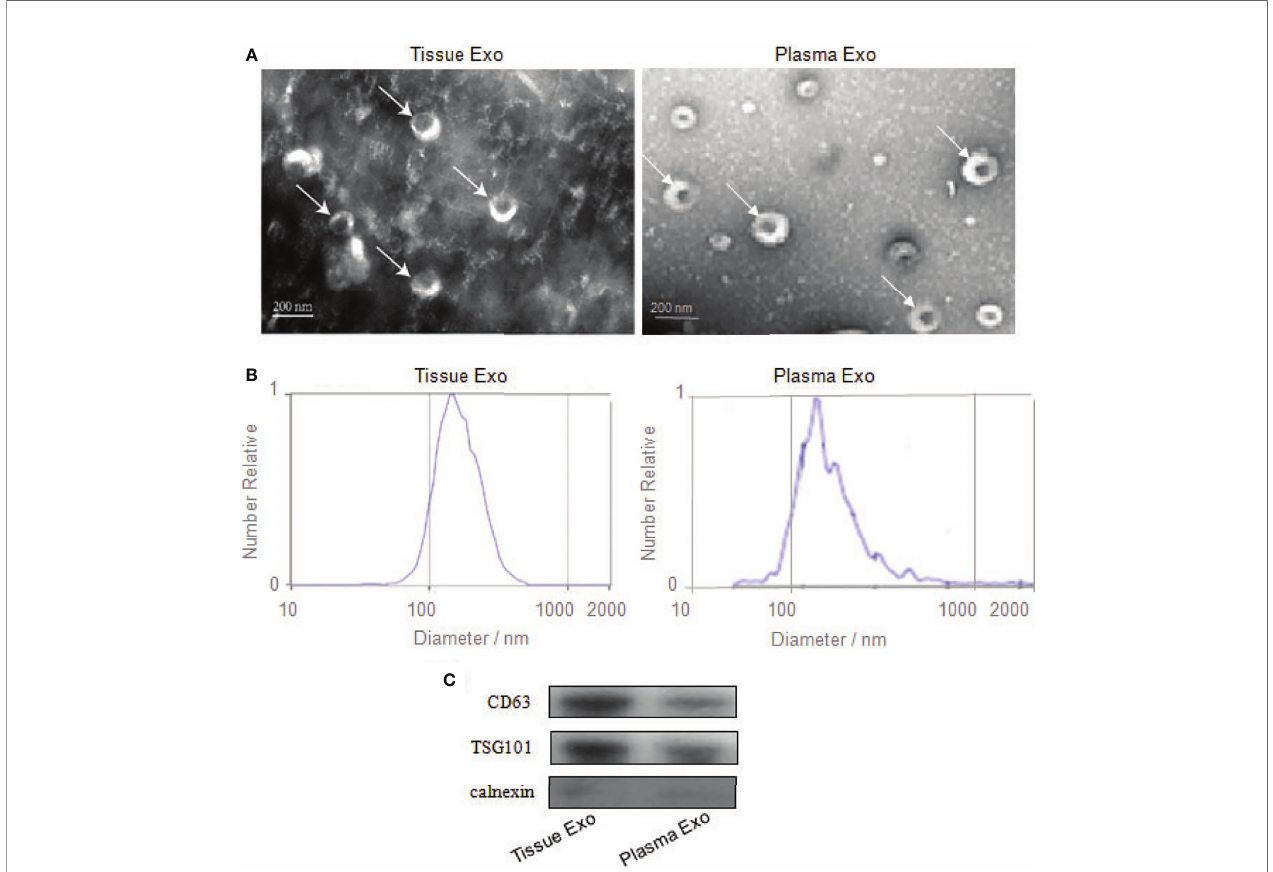
FIGURE 1 | Identi fi cation of exosomes from tissue and plasma. (A) Transmission electron microscopy con fi rmed the presence of exosomes. Scale bar=200 nm. (B) Nanoparticle-tracking analysis determined the sizes of exosomes. (C) Western blotting analyzed the exosomes-enriched positive protein markers of CD63 and TSG101, and negative protein marker of